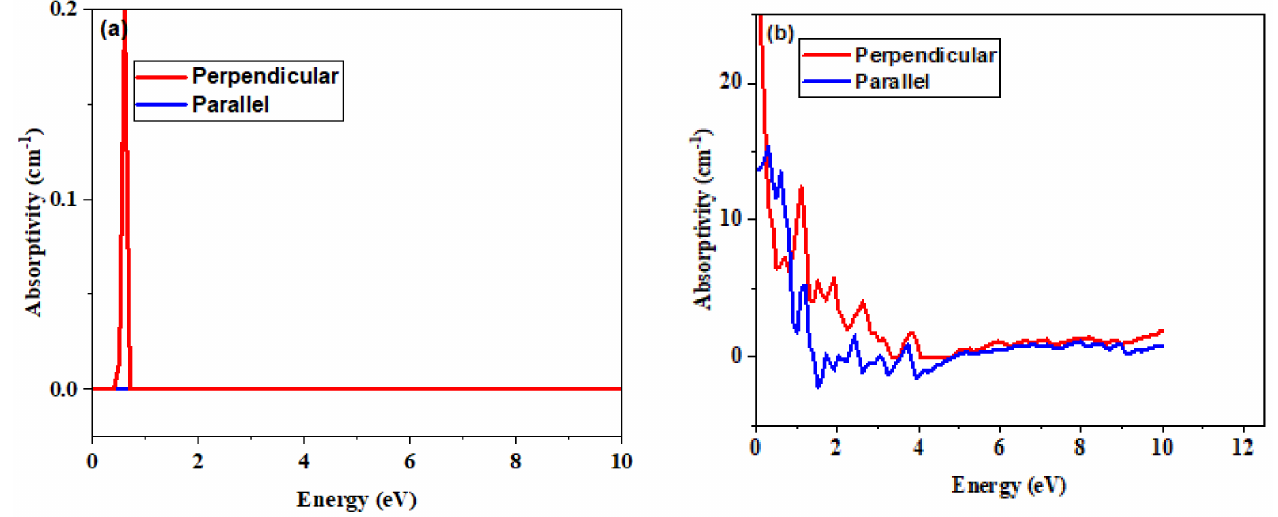
Figure 6. Optical absorptivity of ( a ) armchair (5, 5) SWBNNT and ( b ) armchair (5, 5) SWCNT